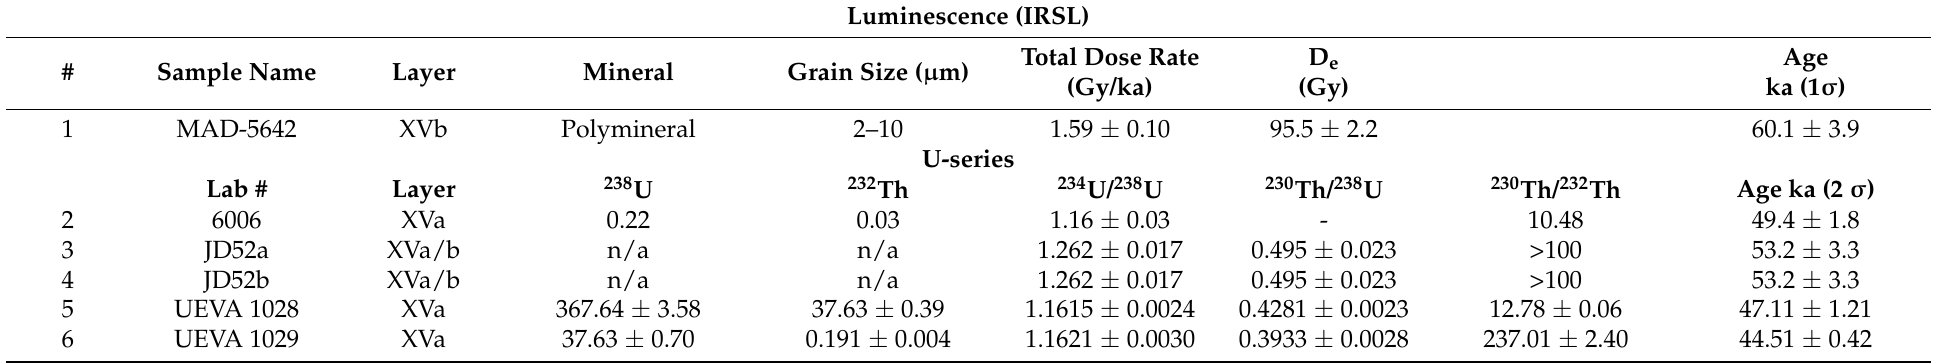
Table 2. Final ages of the GL1 gallery from the Cova del Gegant site. Luminescence mean ± total uncertainty (1 σ or 68% confidence interval), calculated as the quadratic sum of the random and systematic uncertainties. U-series dating results for speleothems from Cova del Gegant (2 σ confidence interval). All ratios are activity ratios calculated from isotope concentration ratios using decay constants according to Jaffey et al. [67] ( λ 238), Cheng et al. [68] ( λ 234 and λ 230) and Holden [69] ( λ